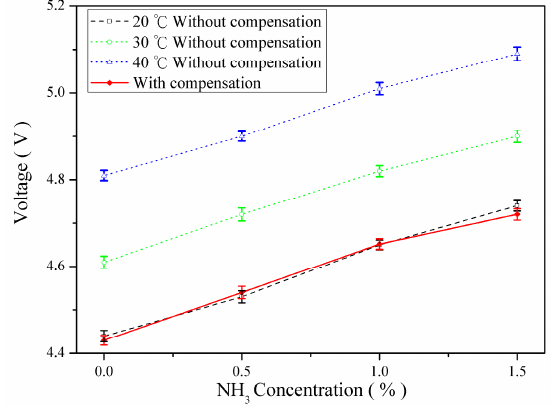
Figure 13. Comparison of NH 3 concentration–voltage response relationships before and after temperature compensation.